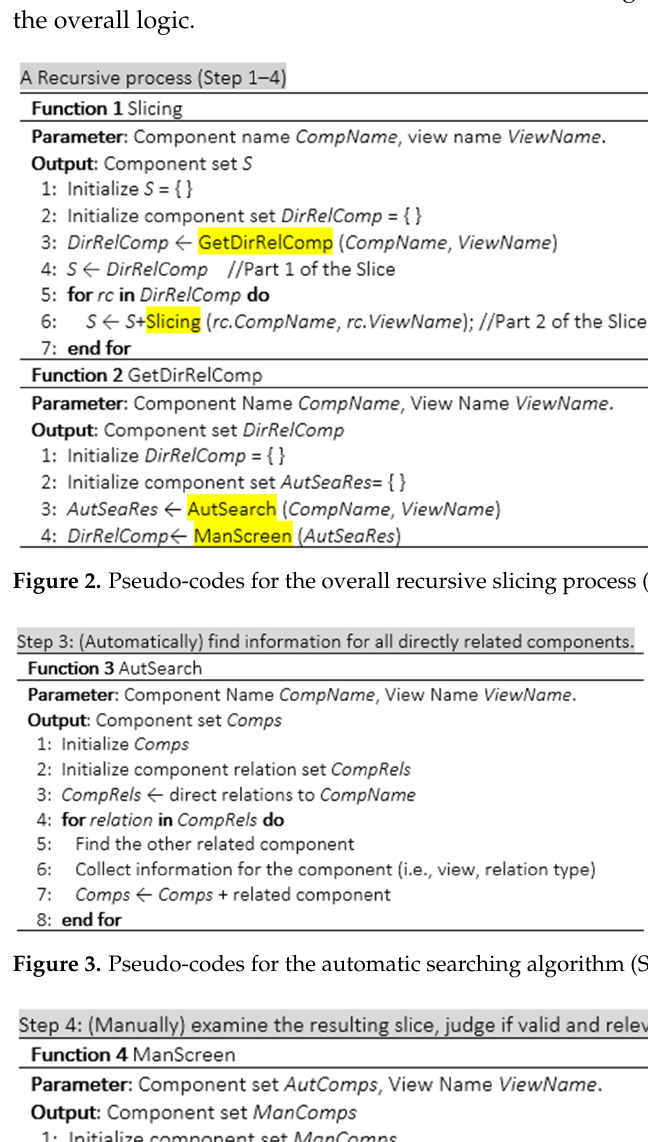
Figure 1. The process of the proposed EAS method.